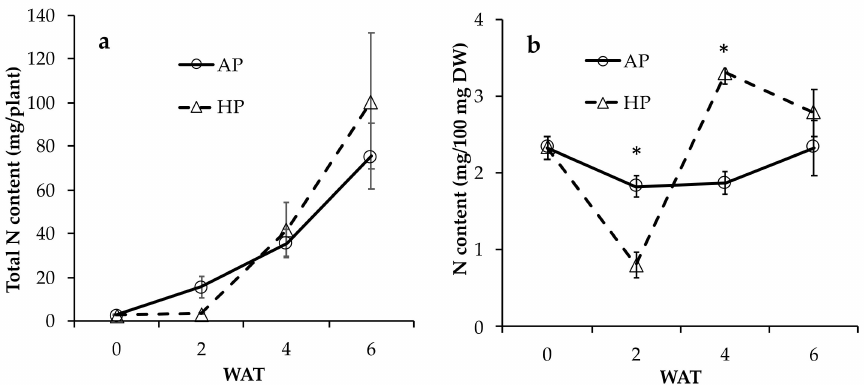
Figure 3. Total nitrogen ( a ) and nitrogen concentration ( b ) in leaf of lettuce in aquaponics (AP) and hydroponics (HP) at 0, 2, 4, and 6 weeks after transplant (WAT) in Exp. 2. Mean ± SE (n = 4). * indicates significant difference according to t -test ( p < 0.05).